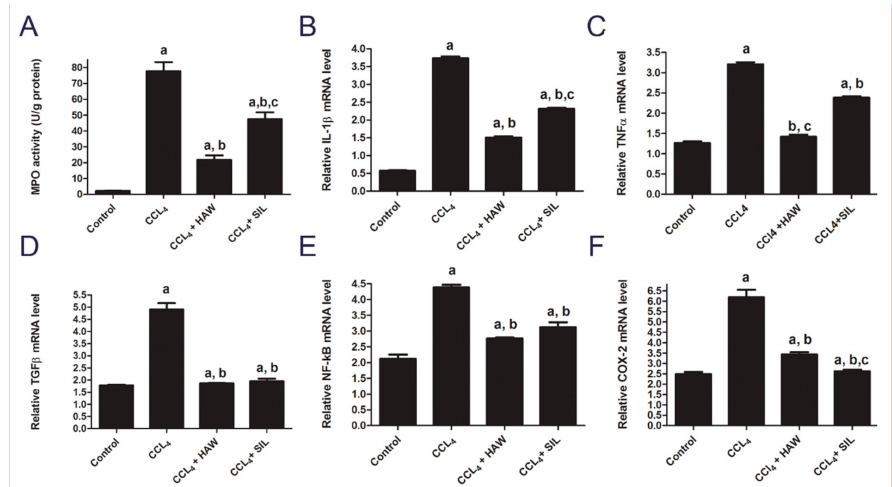
Figure 4. HAW inhibited the overexpression of inflammatory factors in rats. ( A ) myeloperoxidase (MPO) activity, ( n = 6 per group) and mRNA expression of ( B ) IL-1 β , ( C ) tumor necrosis factor (TNF- α ), ( D ) TGF β , ( E ) nuclear factor kappa-B (NF-kB), and ( F ) cyclooxygenase-2 (COX-2) in liver tissues ( n = 3 per group). Results of mRNA expression were normalized to GAPDH mRNA. Data are presented as means ± SEM). a is p < 0.05 vs. control group, b is p < 0.05 vs. CCl4 group, and c is p < 0.05 vs. HAW group.